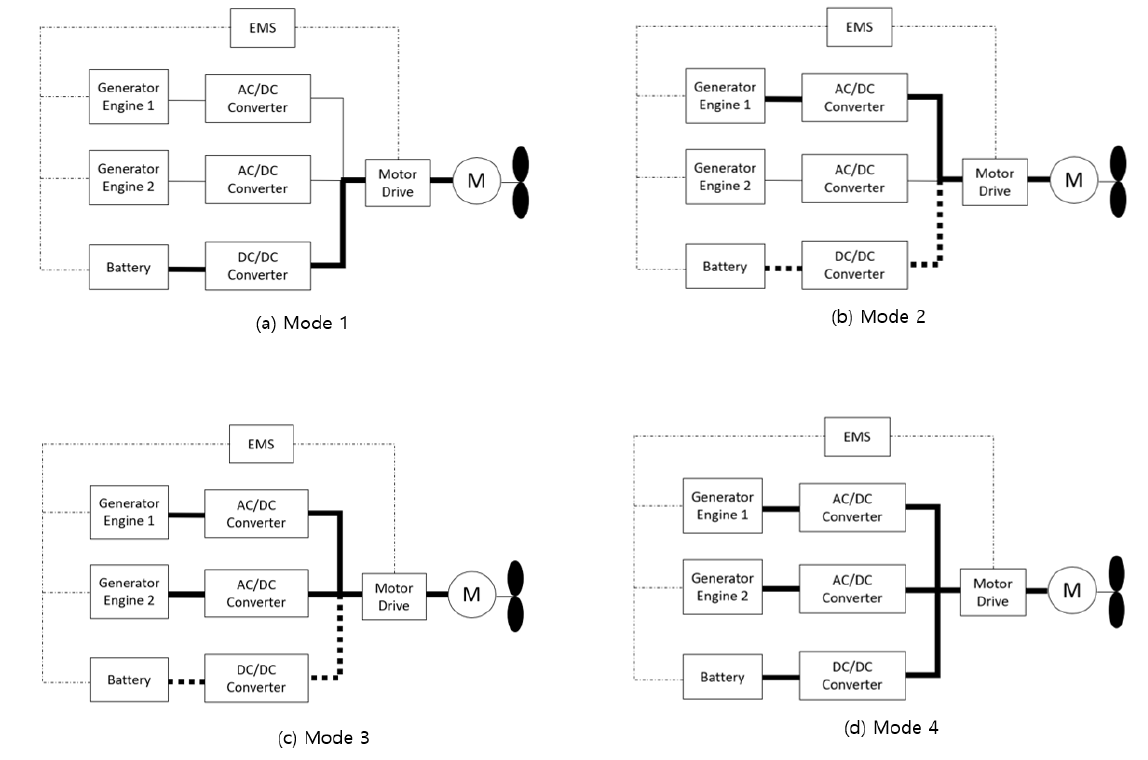
Figure 7. Generator–battery hybrid system operation modes.